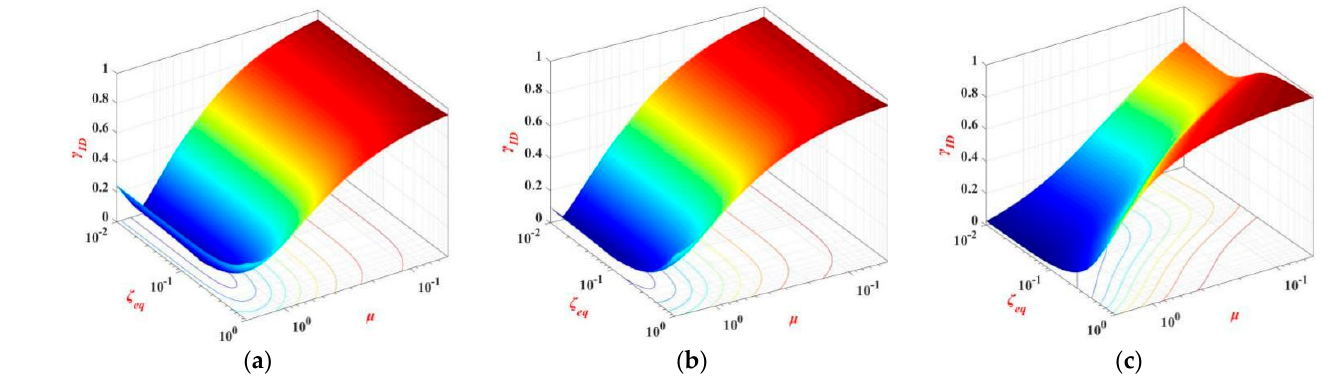
Figure 9. Contour plot of γ U of LB–2 : ( a ) κ = 0.05; ( b ) κ = 0.1; ( c ) κ = 0.3.